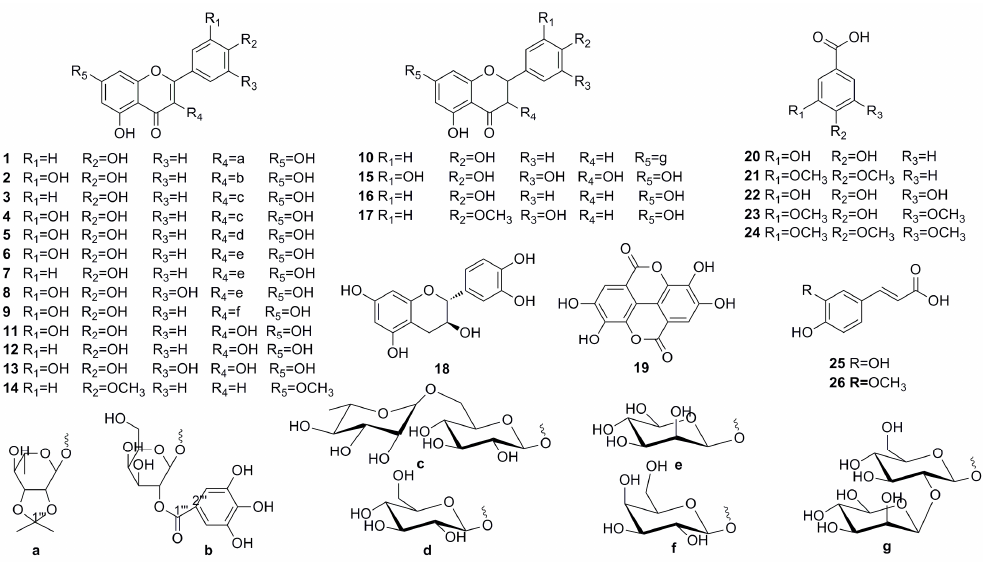
Figure 1. Chemical structures of isolated compounds 1 – 26 ; ( a – g ) are the sugar groups of